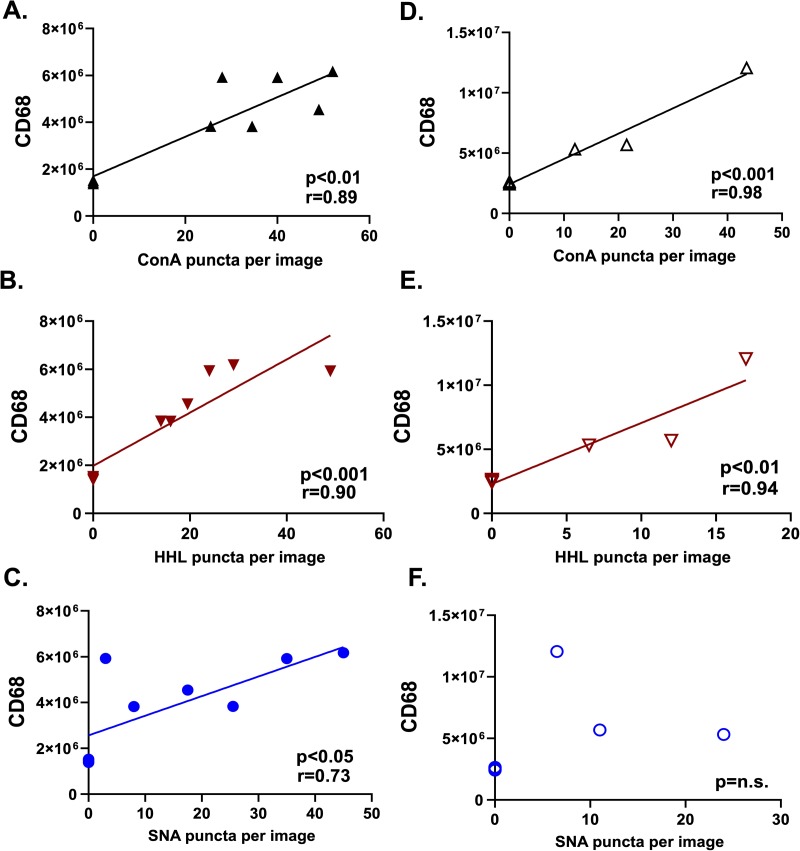
CD68 macrophage staining positively correlates with HM-ICAM-1 in animal models of atherosclerosis.A-C. CD68 staining (fluorescence) as a function of ConA, HHL, and SNA puncta, respectively, for ApoE-/- mice fed HFD diet. n = 6 animals; n = 12 paired lesion and non-lesion vessel areas. D-F. CD68 staining (fluorescence) as a function of ConA, HHL, and SNA puncta, respectively, for ApoE-/- mice after partial carotid ligation n = 3 animals; n = 6 vessel samples. Best fit lines determined by linear regression with Pearson correlation analyses with indicated coefficients and p-values shown in each panel.